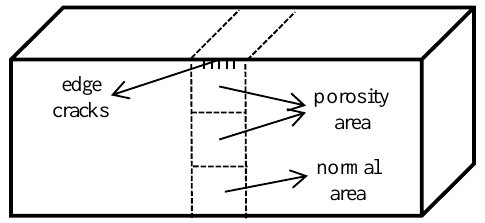
Figure 1. Sampling position.